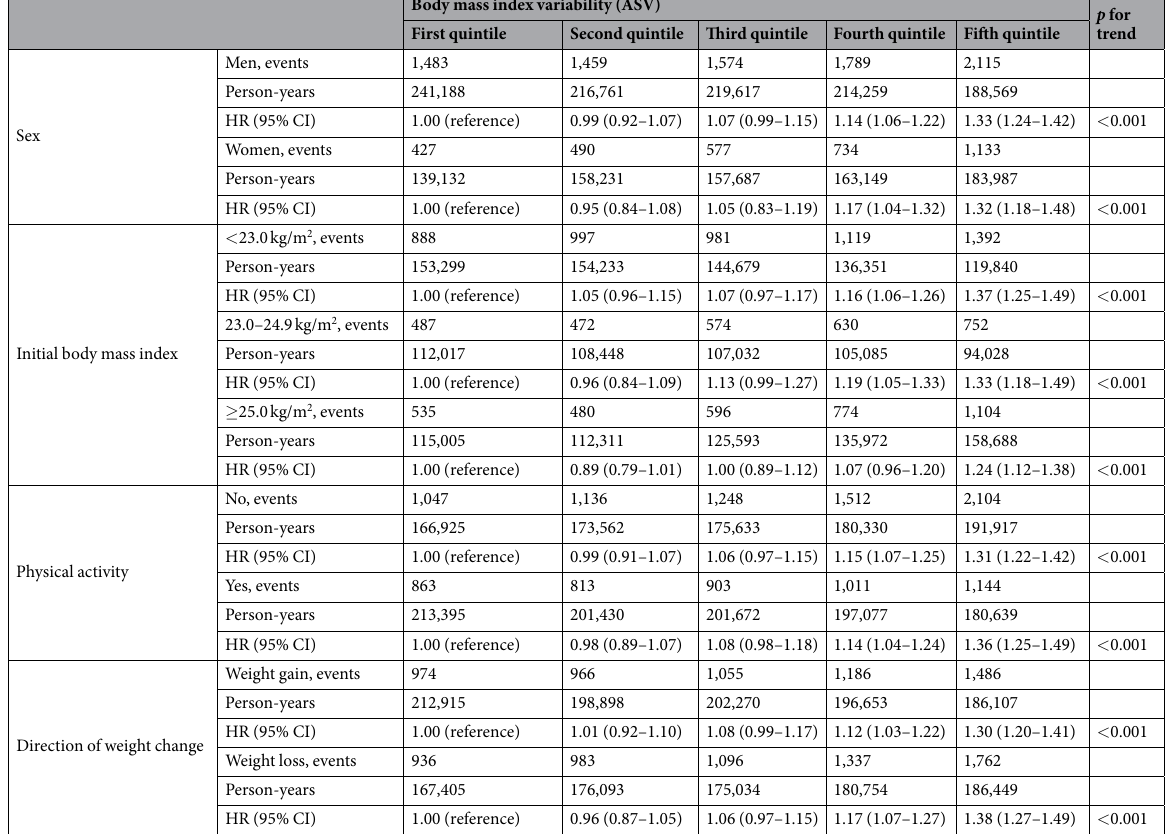
Table 3. Stratified analysis of the effect of weight variability on death from all causes according to subgroups of sex, initial body mass index, physical activity, and direction of weight change. Hazard ratio calculated by Cox proportional hazards regression analysis after adjustments for age, sex, baseline body mass index, change in body mass index, household income, smoking, alcohol consumption, physical activity, systolic blood pressure, fasting serum glucose, total cholesterol, underlying cancer, and underlying cardiovascular disease. Acronyms: ASV, average successive variability; HR, hazard ratio; CI, confidence